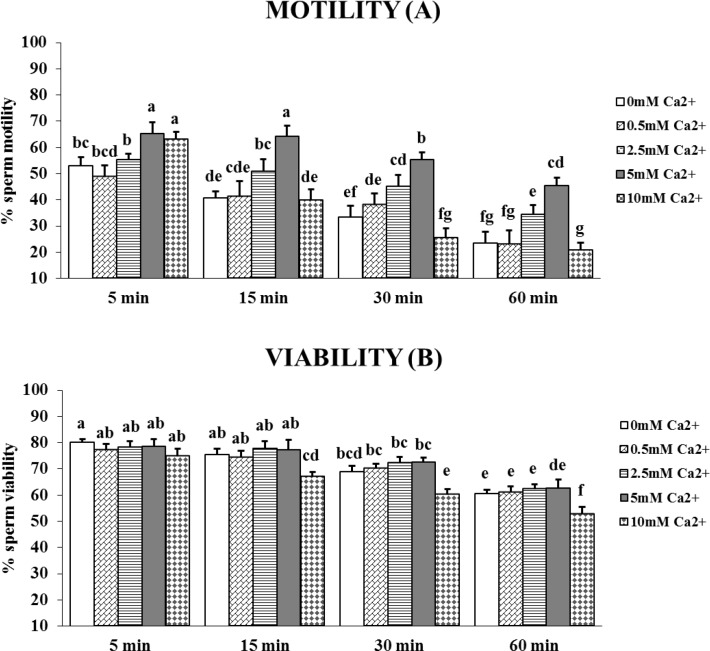
Effect of extracellular Ca2+ on chicken sperm motility and viability.Sperm were incubated for up to 60 min at 35°C in medium without Ca2+ (white) or containing different concentrations of Ca2+: 0.5mM (diagonal brick bars), 2.5mM (horizontal bars), 5mM (grey bar), 10mM (diamond bars). The percentages of motile (A) and viable (B) sperm after 5, 15, 30 and 60 min of incubation were determined as described in the Materials and Methods section. The results are expressed as mean ± SEM, n = 6. Different superscripts indicate statistically significant differences (P < 0.05).